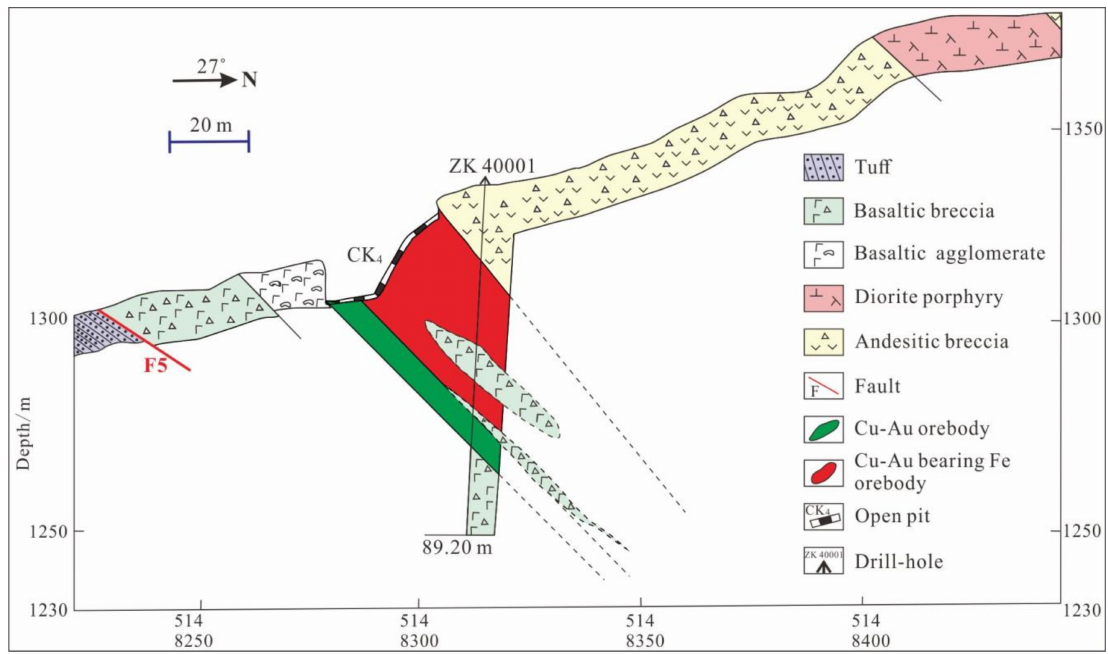
Figure 3. Cross section along the No. 0 prospecting line in the Laoshankou Fe-Cu-Au deposit (modified from Xinjiang Geological Survey,